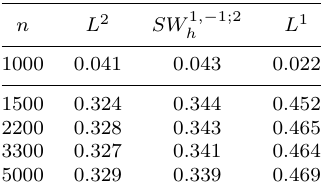
Table 3. Practical errors and error orders in Example A m